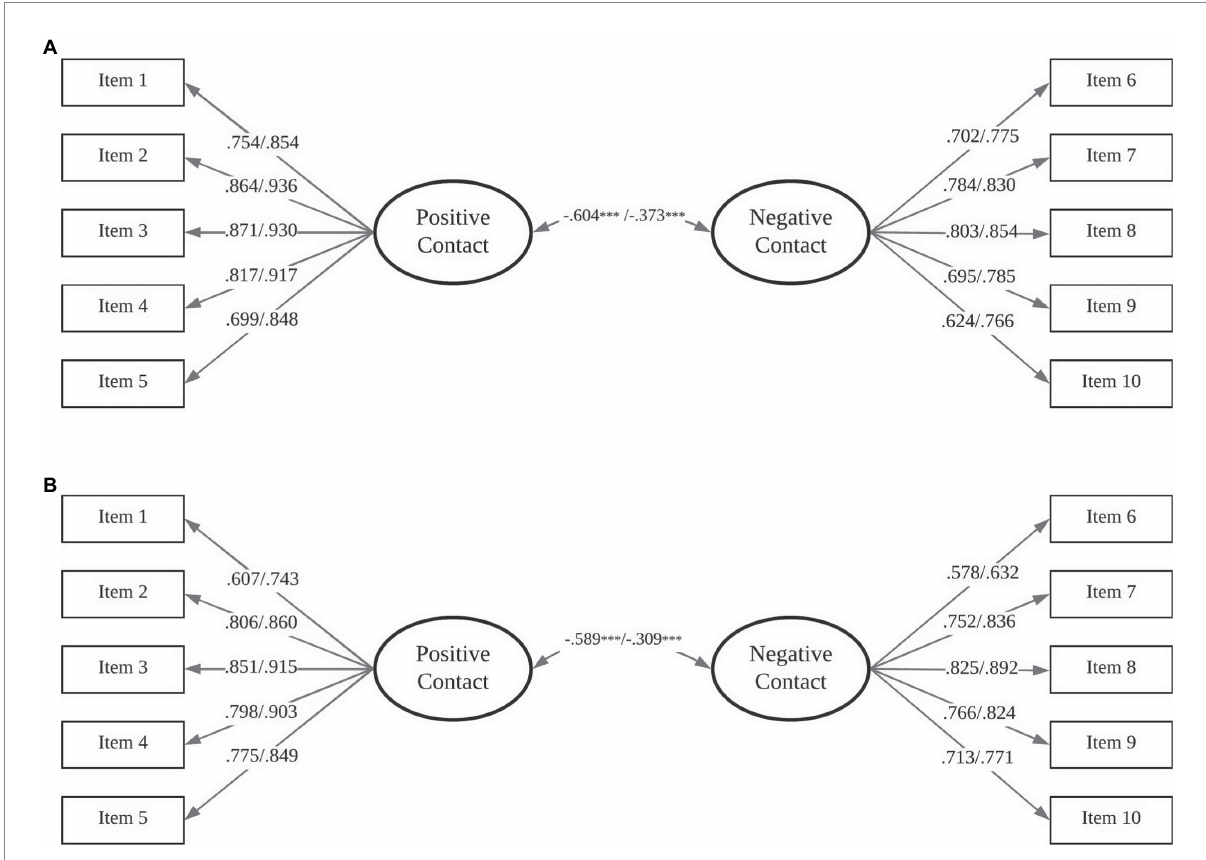
FIGURE 1 Factor loadings for the ICIS in Studies II (A) , and III (B) . The values presented on the left side of the slash marks indicate the standardized factor loadings of the positive and negative contact in school context, whereas the values displayed on the right side of the slash marks indicate the standardized factor loadings of the positive and negative contact in out-of-school contexts. All factor loadings and correlations are significant at p <